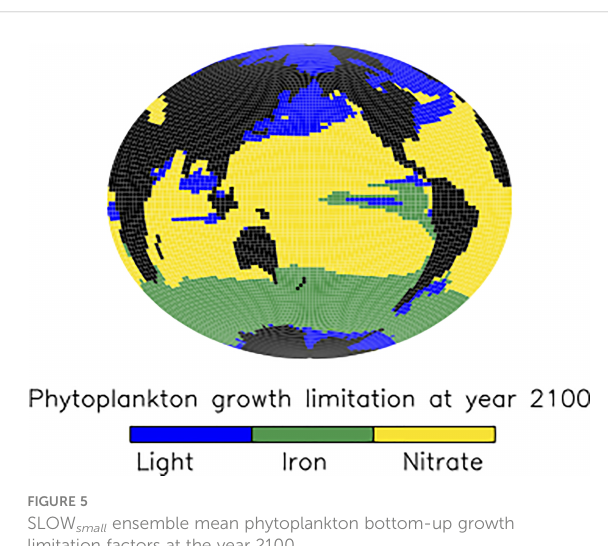
FIGURE 5 SLOW small ensemble mean phytoplankton bottom-up growth limitation factors at the year